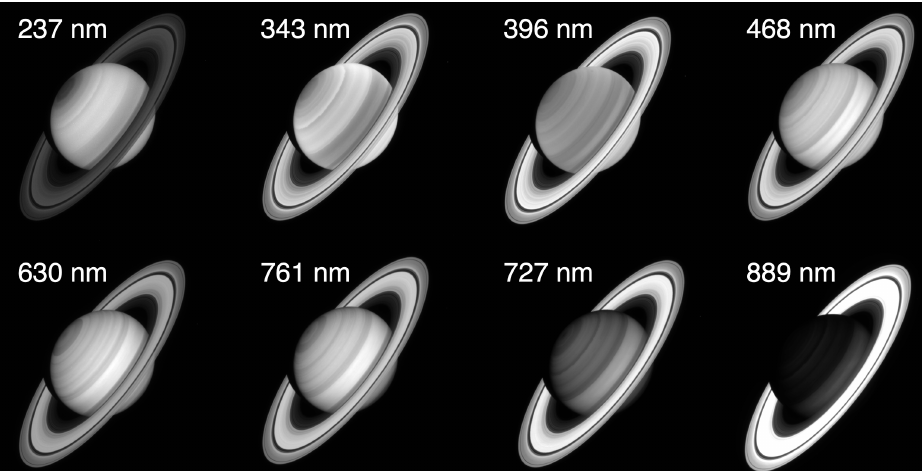
Figure 6. Saturn’s appearance at UV and visible wavelengths. September 2021 Hubble data show Saturn’s cloud band variations with wavelength. At visible wavelengths, Saturn’s cloud bands are clearly seen, and the planet is very dark in the 889 nm methane absorption band.